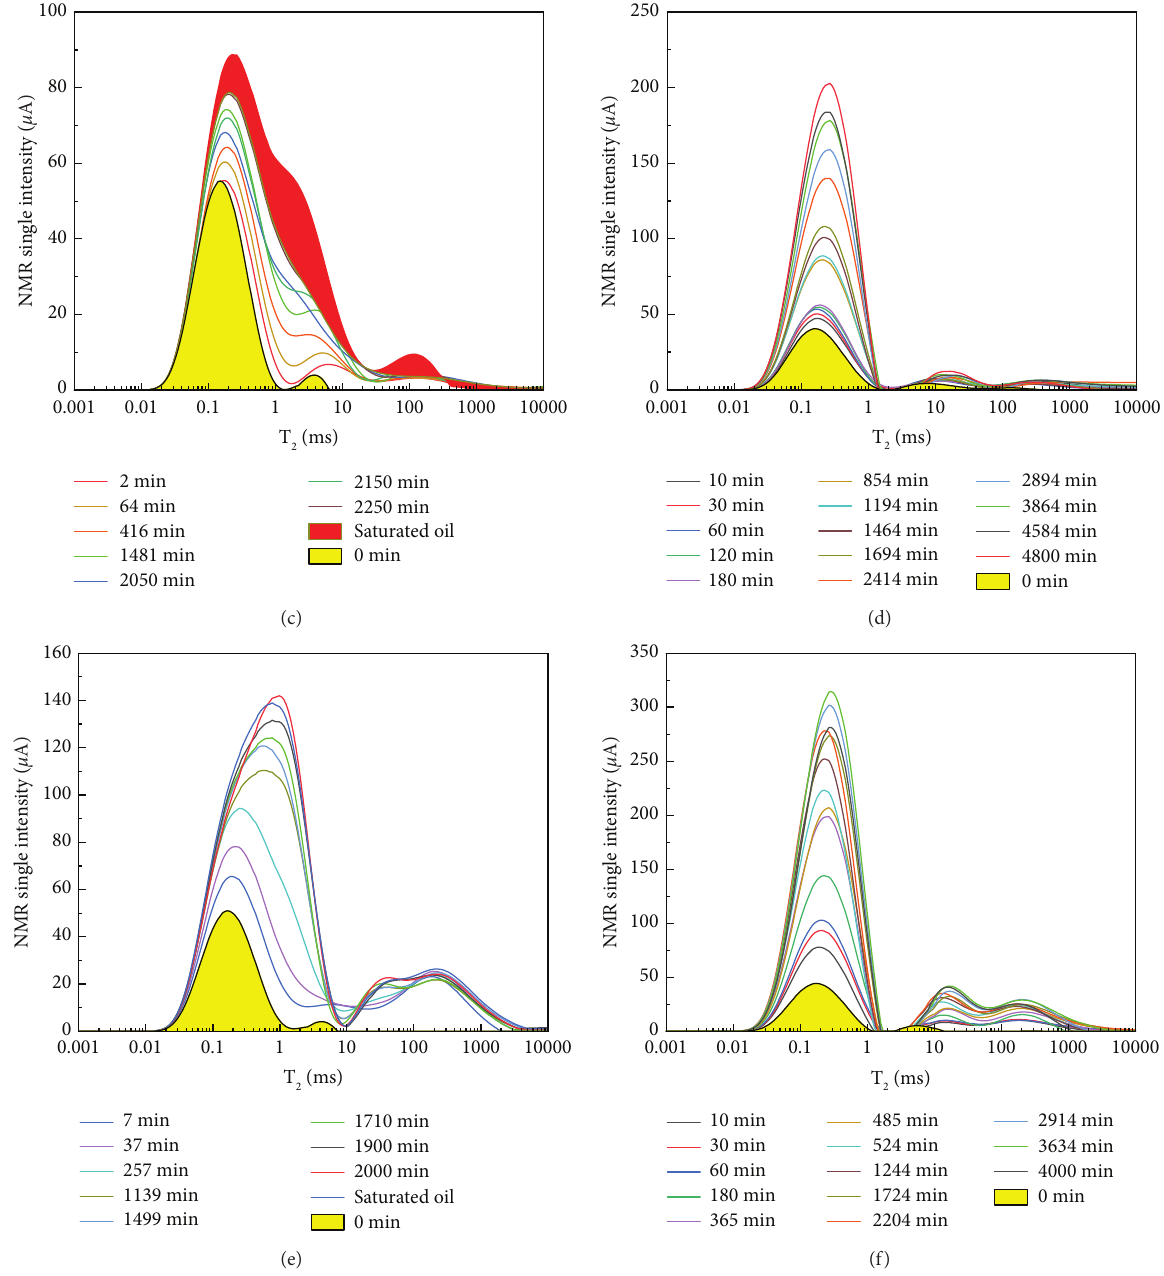
Figure 6: Microscopic characteristics of percolation of n-dodecane and water from different lithofacies samples. (a) Sandy interlayer oil imbibition YY-72-2. (b) Sandy interlayer water imbibition YY-72-2. (c) Low organic matter laminated siliceous shale oil imbibition